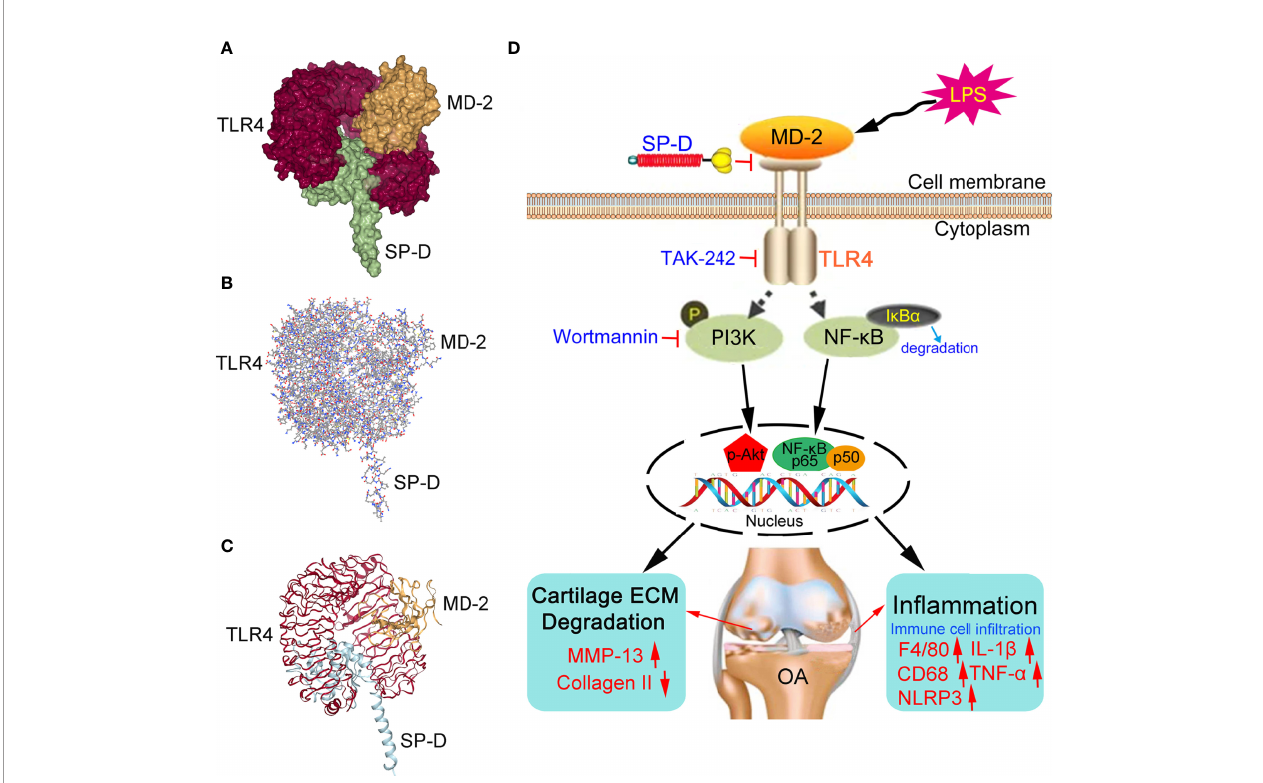
FIGURE 10 | Proposed mechanisms of SP-D interference with OA chondrocyte in fl ammatory response and cartilage degradation. (A – C) The spatial fi lling model illustrated that SP-D was fully embedded in the inhibitory pocket of TLR4/MD-2 homodimer complex. The surface of SP-D binds to TLR4/MD-2 homodimer complex with average generalized born score of -25.03 kcal/mol and average poisson-boltzmann of -46.87 kcal/mol. (D) SP-D as a modulator of in fl ammatory response via inhibition of TLR4-mediated NF- k B activation and PI3K/Akt